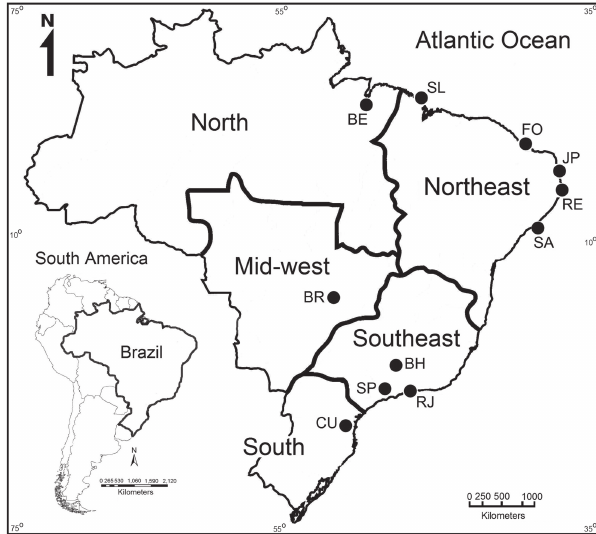
Fig. 1. Five main geopolitical regions of Brazil and the 11 cities where we monitored the unregulated market of juveniles of non-native large fishes. Brazilian cities/population/states surveyed: BE - Belém/1,446,042 inhabitants/Pará, SL - São Luís/1,082,935 inhabitants/Maranhão, FO - Fortaleza/2,609,716